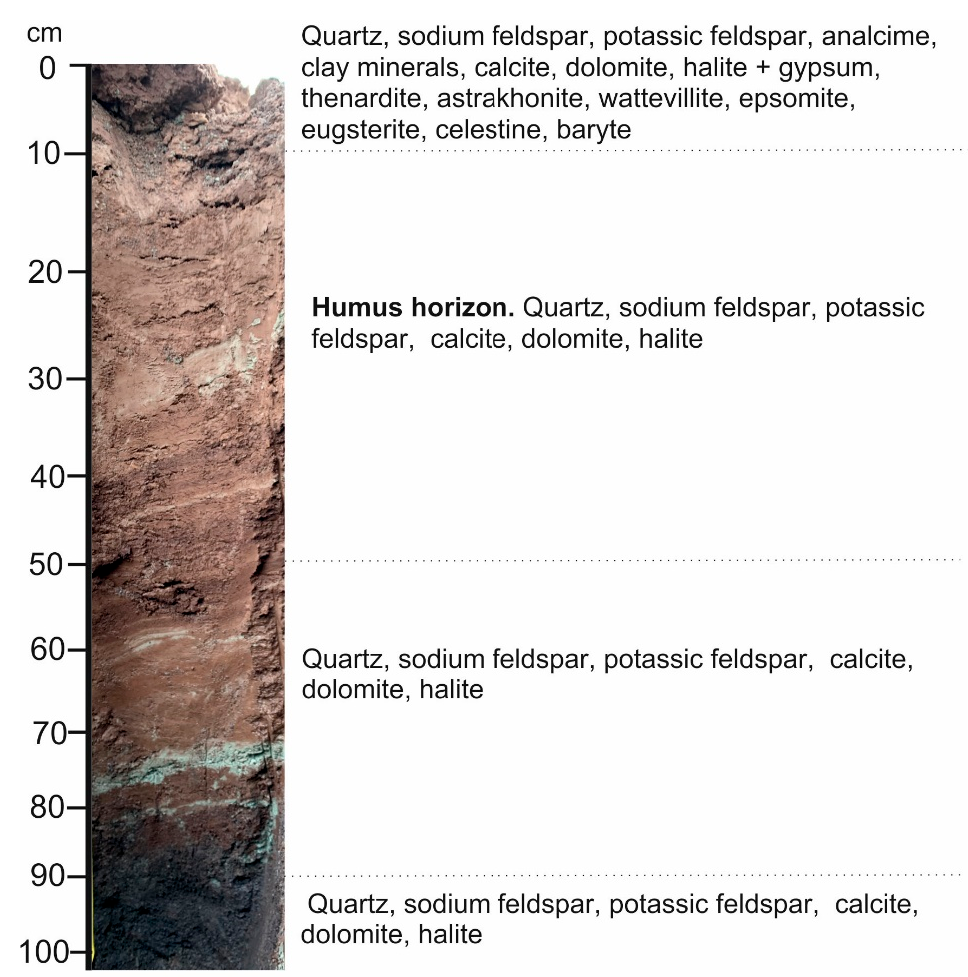
Figure 2. Distribution of minerals in the sediments of Lake Taloe in the section.